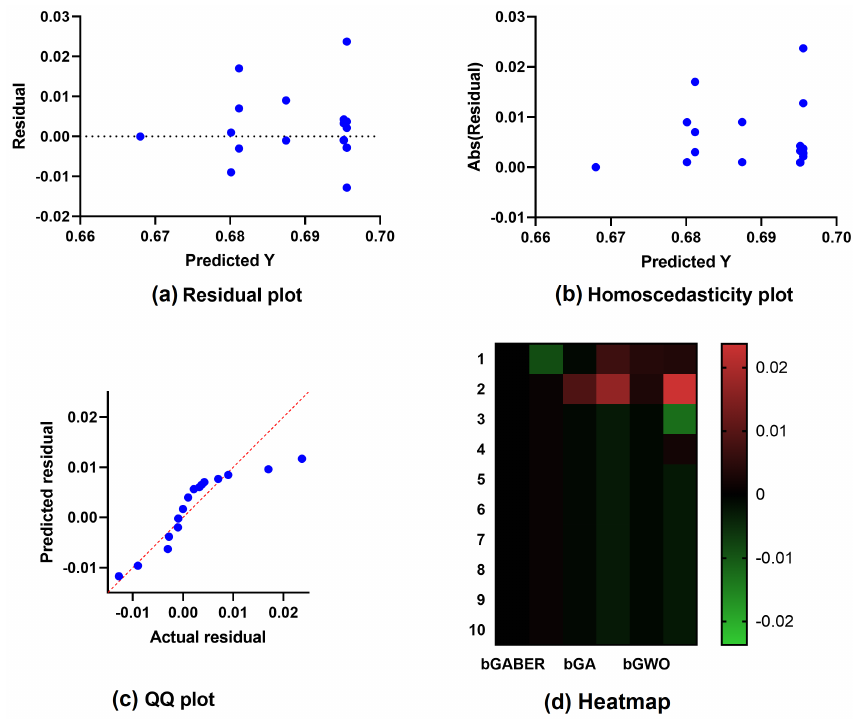
Figure 9. Visualizing the performance of the proposed feature selection method applied to wind speed